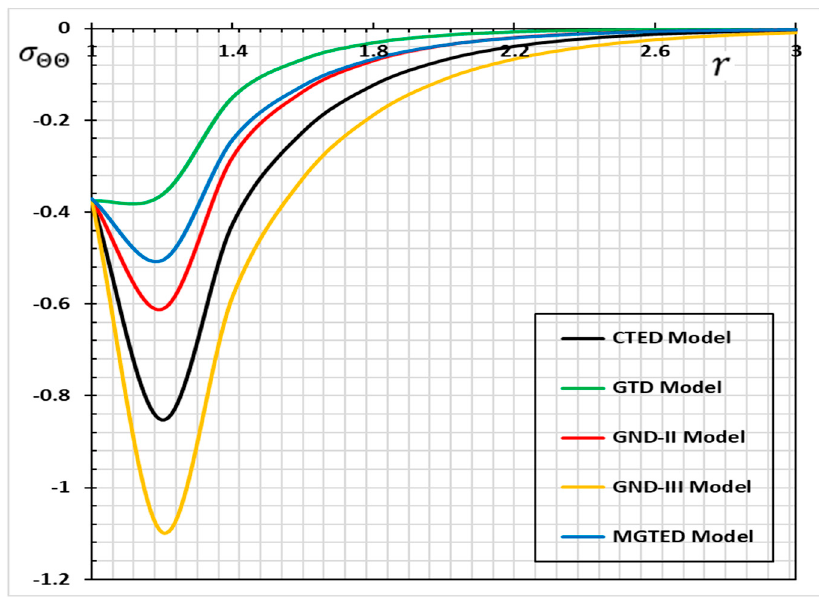
Figure 4. The hoop stress 𝜎 (cid:2944)(cid:2944) for different thermo-diffusion models.